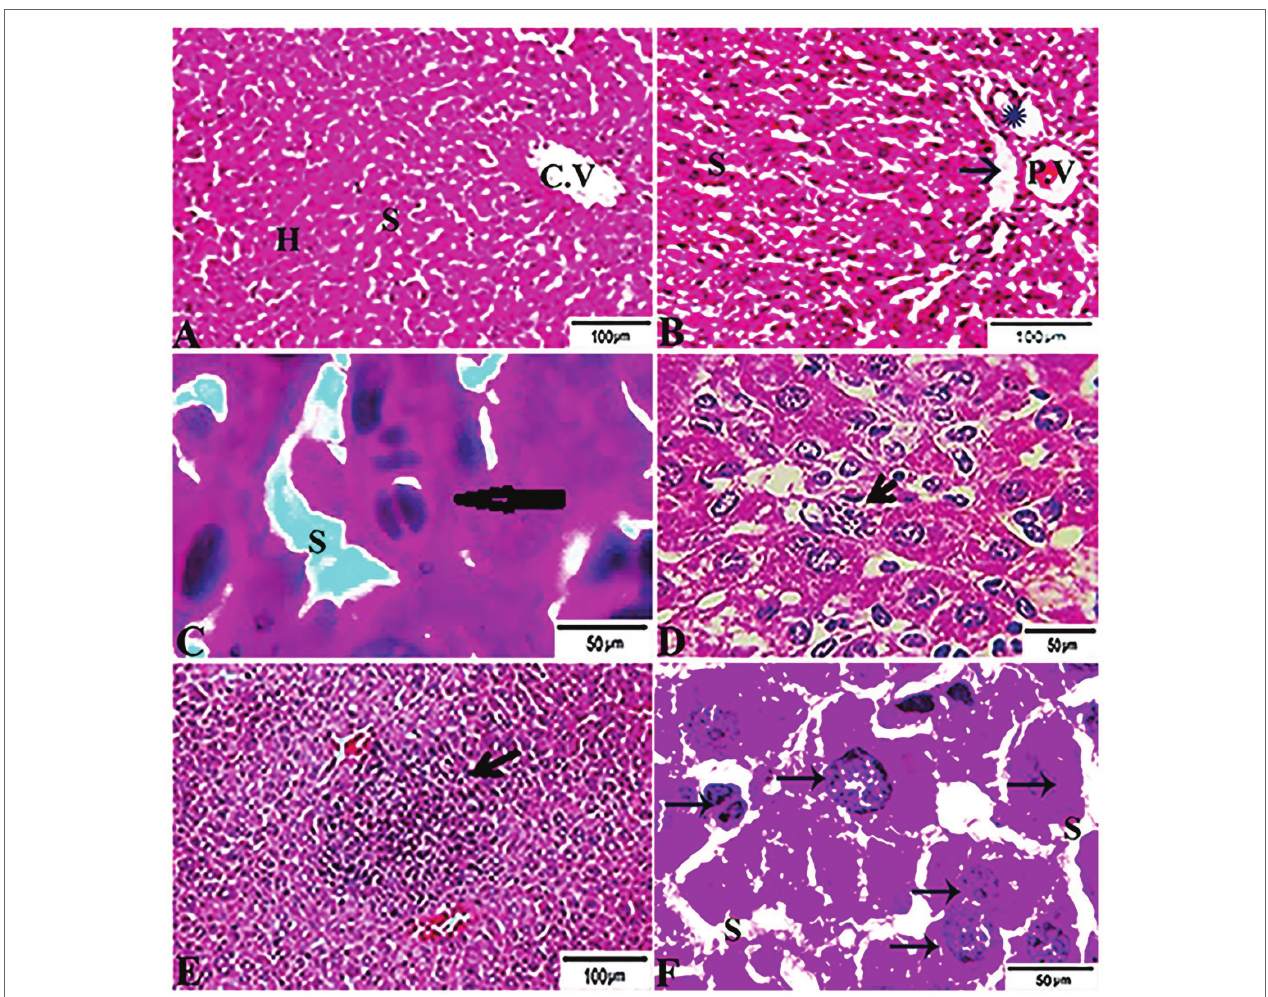
FIGURE 4 | Photomicrograph of liver sections from experimental mice groups stained with H&E stain: (A,B) a mice liver from the control group demonstrating normal hepatic architectures. (A) Central vein (CV), sinusoids (S), and Hepatocytes (H). (B) Intact portal area; Portal Vein (P.V), Hepatic artery (arrow), and Bile duct (star). (C) Hepatic tissue section from the control positive group infected by Toxoplasma gondii showing; the presence of bradyzoites appeared as pseudocyst of T. gondii among degenerated hepatocytes (arrow). (D,E) Liver sections from the group treated for 14 days showing: (D) The presence of a cluster of tachyzoites appeared as pseudocyst of T. gondii among some degenerated hepatocytes (arrow), severe dilatation in hepatic sinusoids (S). (E) Focal aggregations of inflammatory cells in hepatic tissue (arrow). (F) Hepatic tissue section from treated group for 28 days showing: severe infested multiple T. gondii tissue cysts in hepatic parenchyma (arrows) which alters hepatic structure. The bar size of each picture was indicated under each